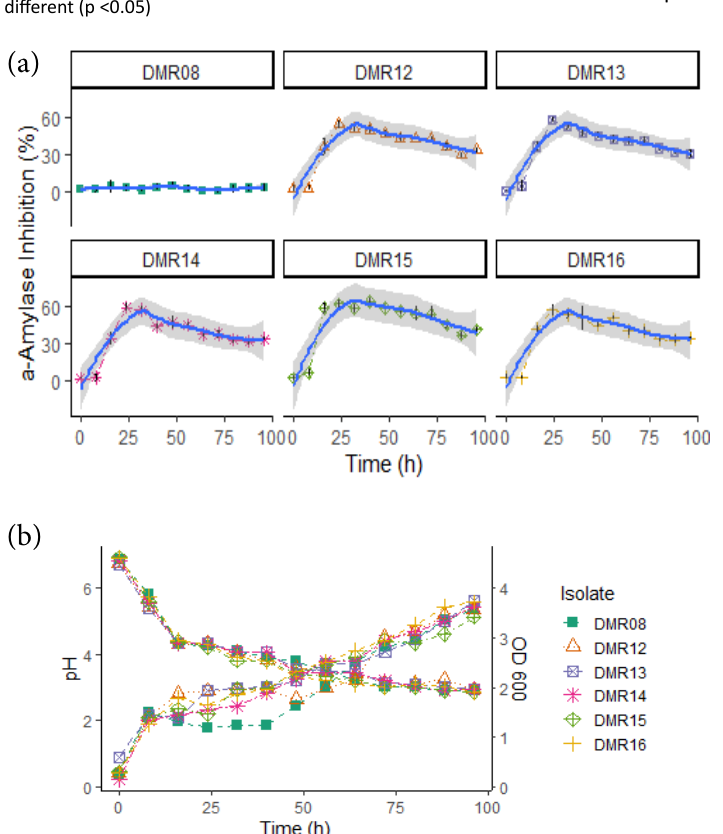
Fig. 3. (a) AAI activities during the growth of LAB isolates. Gray ribbon indicates the local regression line calculated using Loess method (b) pH are shown by descending lines and optical density measured during the growth of the isolates are indicated by ascending lines.